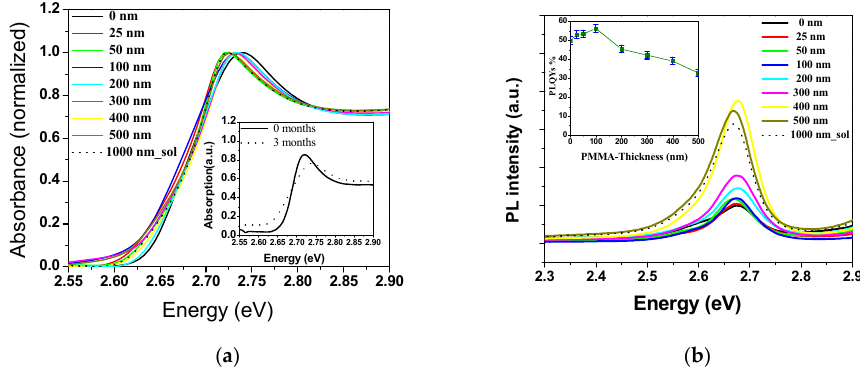
Figure 3. ( a ) Optical absorption spectra, the inset is the time-dependent absorption spectra for CsPb(Br 0.5 Cl 0.5 ) 3 perovskite film; ( b ) emission spectra of CsPb(Br 0.5 Cl 0.5 ) 3 thin films, bare and with various coating thicknesses of polymethyl methacrylate (PMMA) as a passivation layer, the inset is the PMMA thickness-dependent photoluminescence quantum yield (PLQY). Modulus error bars are ± 2-unit standard deviation. Table 1. Optical band gap e.g., exciton and photoluminescence (PL) peak positions, full-width at half-maximum (FWHM) of the exciton and photoluminescence (PL) of CsPb(Br 0.5 Cl 0.5 ) 3 thin films, bare and with various thicknesses of polymethyl methacrylate (PMMA) as a passivation layer.